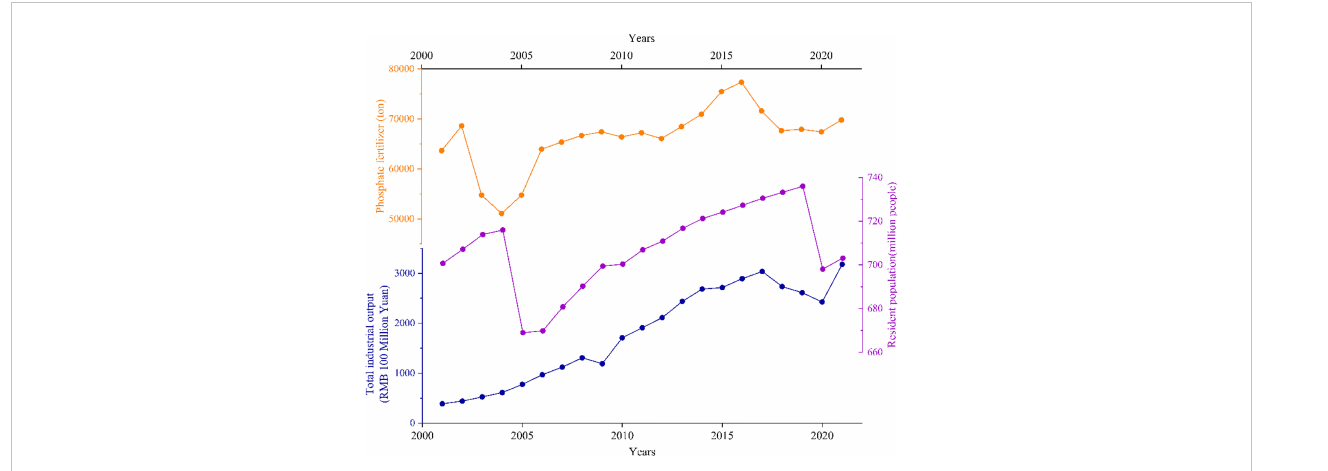
FIGURE 6 Temporal changes in phosphate fertilizer, resident population and industrial scale (total industrial output) in Zhanjiang from 2000 to